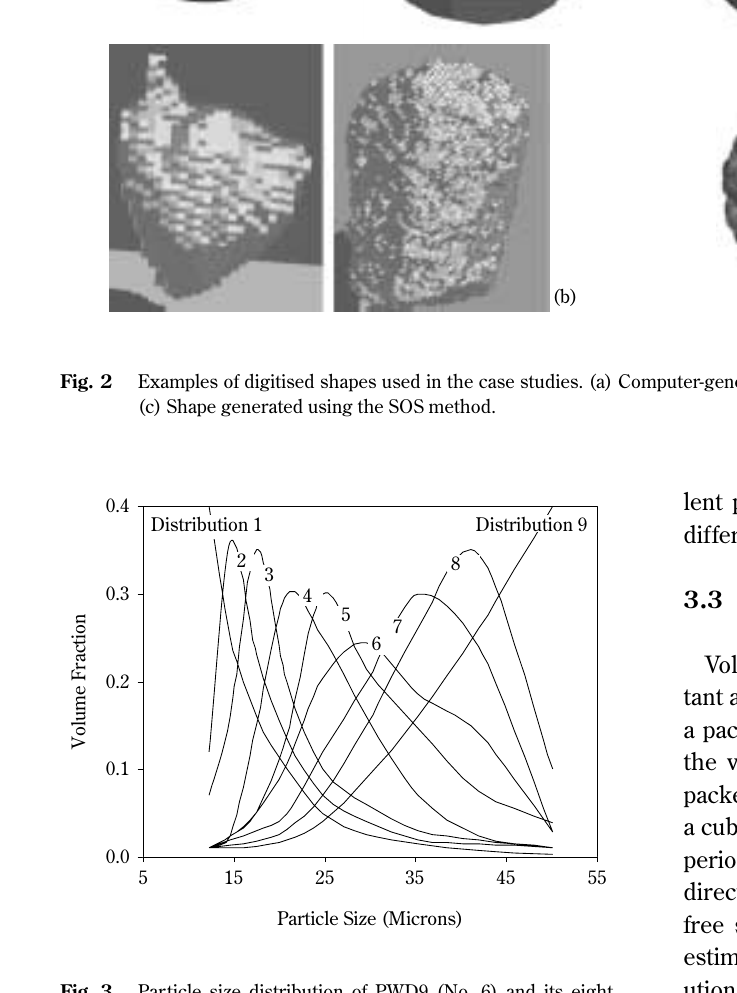
Fig. 3 Particle size distribution of PWD9 (No. 6) and its eight